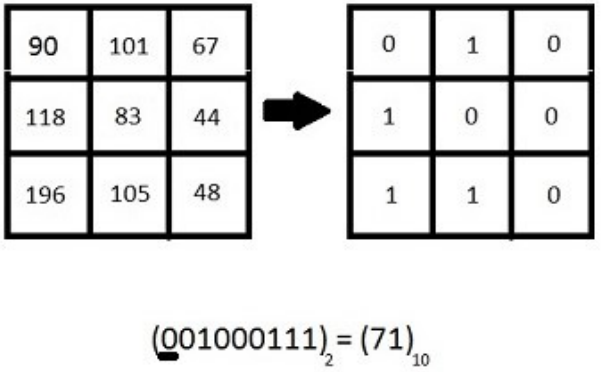
Figure 2. Illustration of ILBP value generation for a 3 × 3 gray image window, where M = 8, Radius = 1 and I mean = 94. The bit representing the center pixel has been underlined in the binary representation of the LBP value.